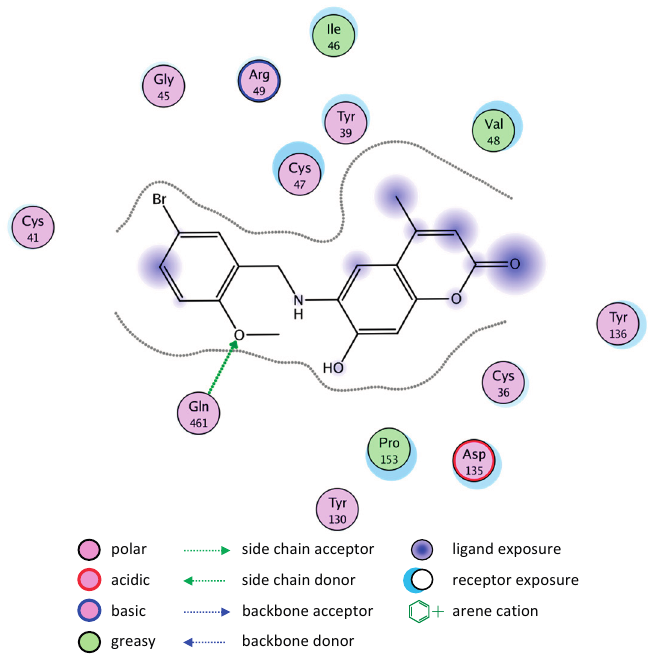
Figure 11. 2D representation of docking of compound 7 into the COX-1 active